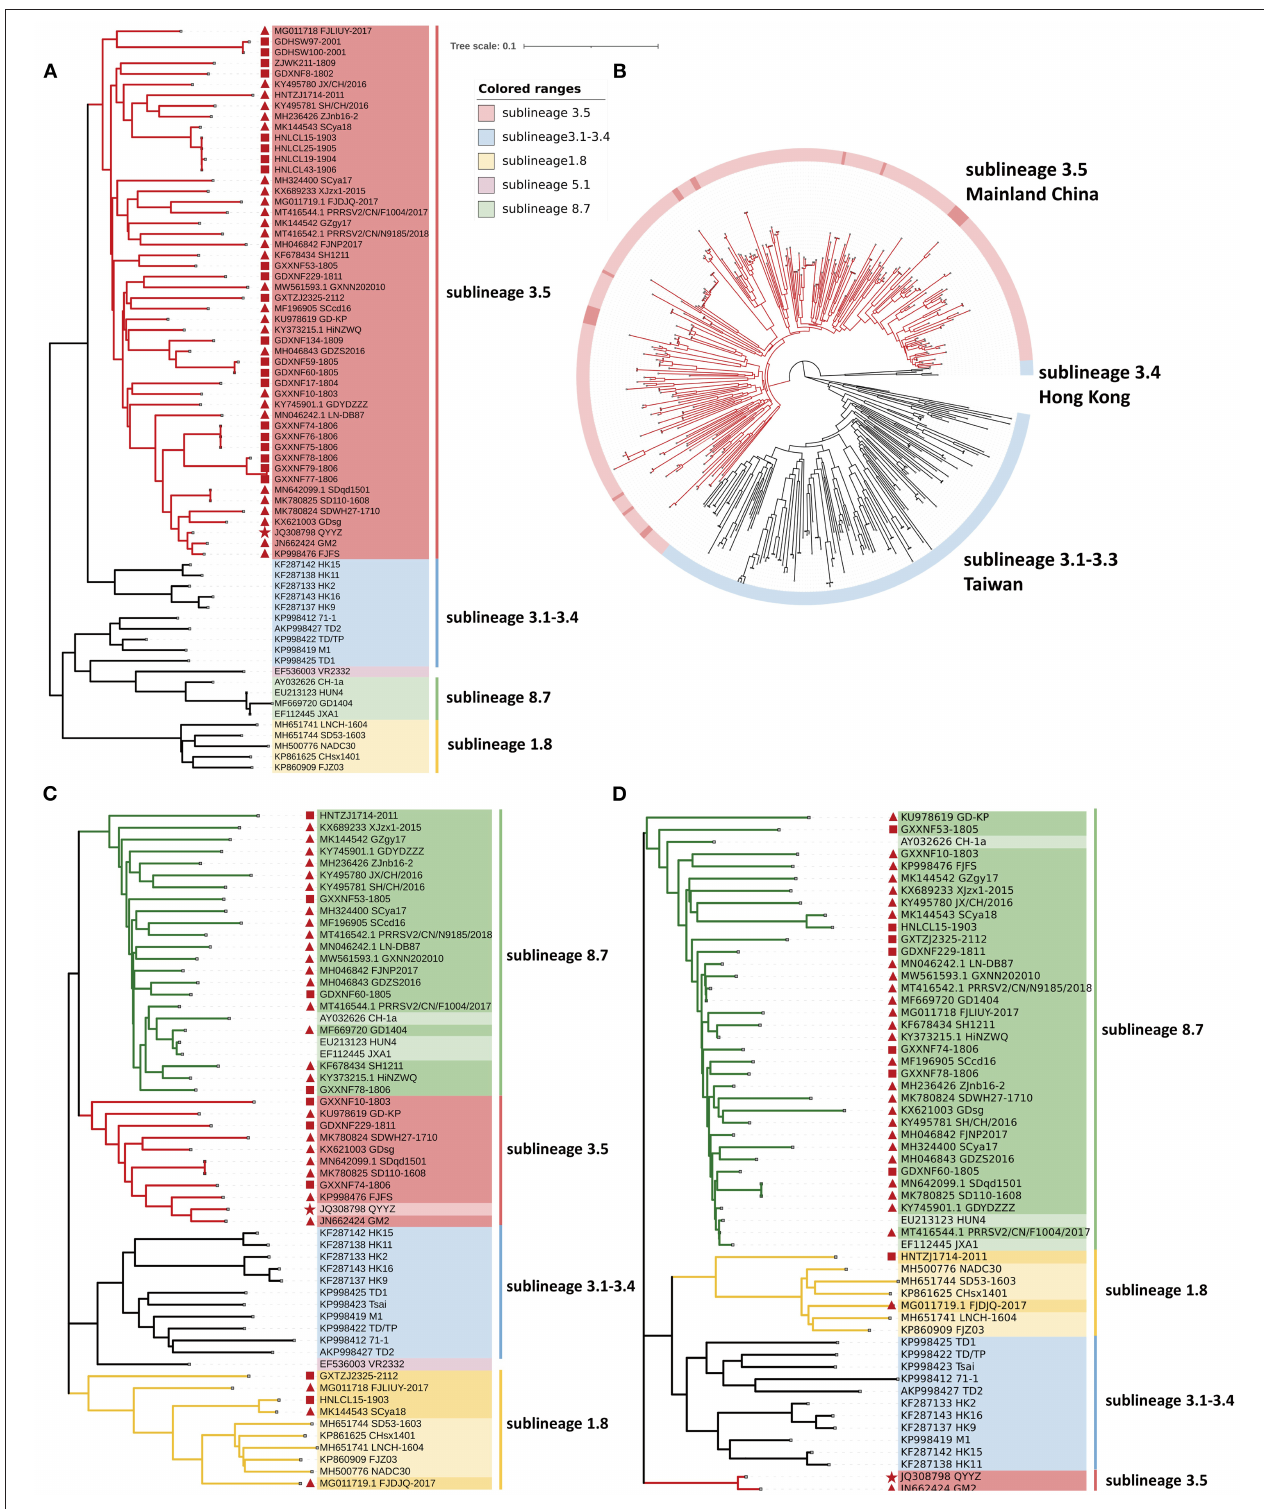
FIGURE 2 | Phylogenetic analysis of QYYZ-like PRRSVs. (A) Phylogenetic tree constructed based on the ORF5 gene of novel QYYZ-like PRRSV isolates and reference PRRSV strains from each lineage. (B) Phylogenetic tree reconstructed based on the global data set ( n = 470) of the lineage 3 PRRSV ORF5 genome. (C) Phylogenetic tree constructed based on full-length genomes of 37 QYYZ-like PRRSV isolates and reference PRRSV strains from each lineage. (D) Phylogenetic tree